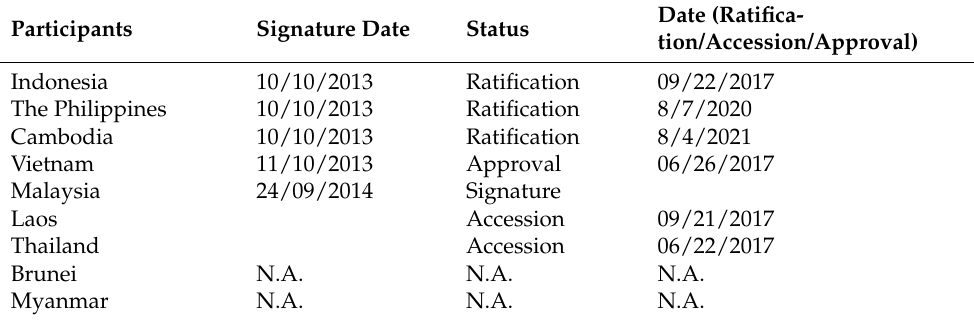
Table 1. Minamata Convention status in ASEAN countries